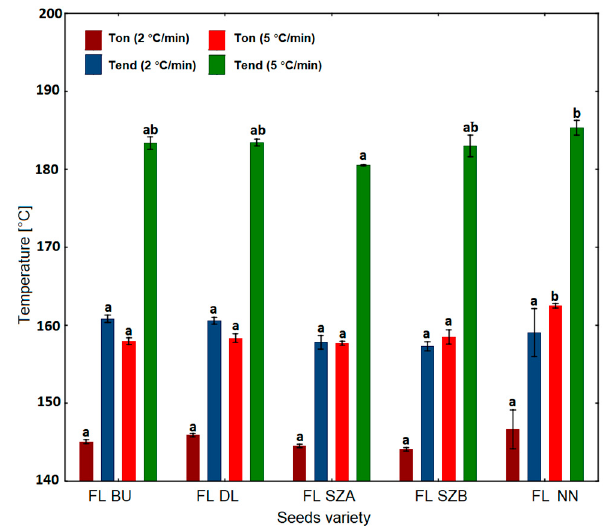
Figure 8. Oxidative stability parameters of five cold-pressed flaxseed oils determined non- isothermally by DSC at a scanning rate of 2 and 5 °C/min. Different letters (a, b) indicate significant differences ( p < 0.05). FL BU (Bukoz Flaxseed cultivar), FL DL (Dolguniec Flaxseed cultivar), FL SZA, FL SZB (Szafir Flaxseed cultivar), FL NN (Unknown Flaxseed cultivar).